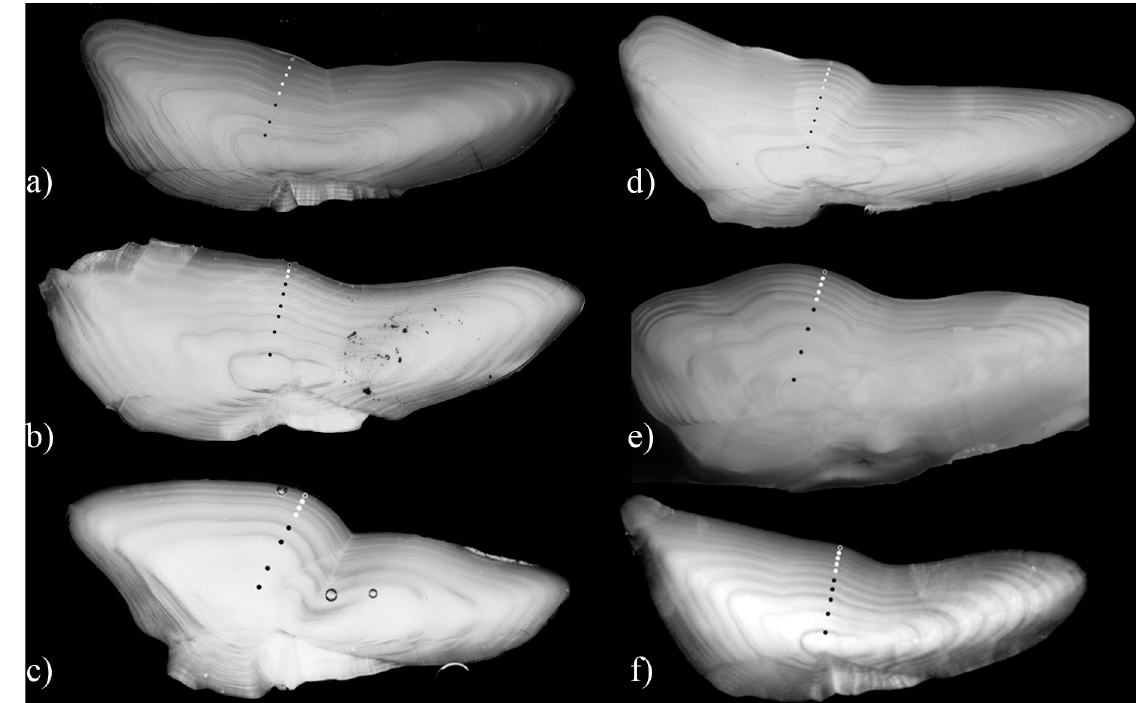
Fig 3. Annotated examples of otoliths with visible spawning zones. NEA cod (a), NCC (b), NS cod (c), Icelandic cod (d), Greenland cod (e) and Cape Breton cod (f). Spawning zones shown as white circles.